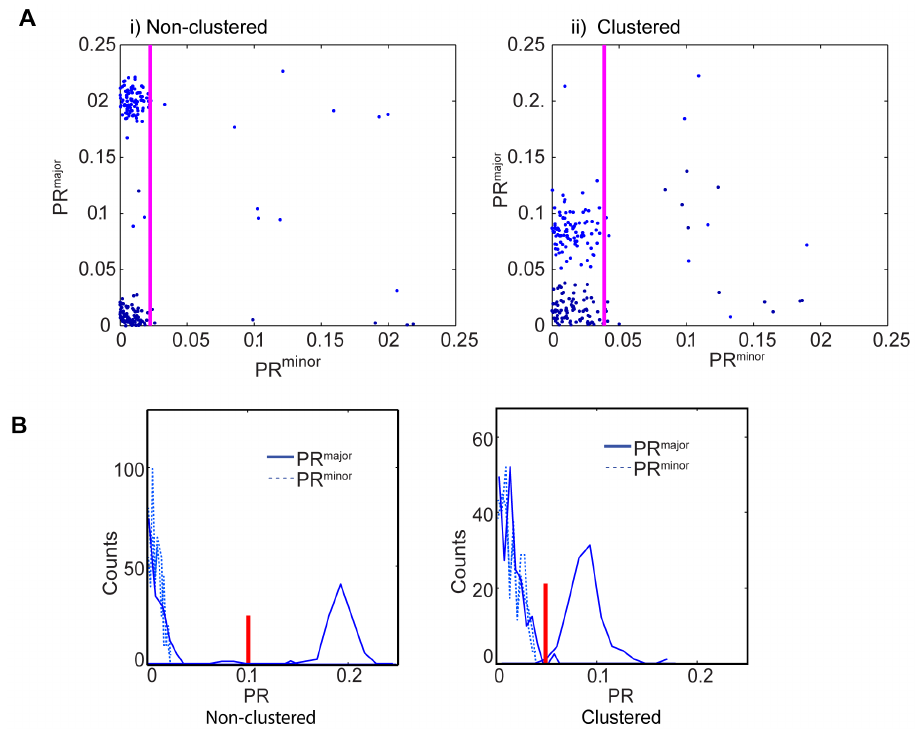
Figure 6. Gating based on PR minor in simulated data. Cell divisions were simulated with ratio 1 (blue color) or 1.5 (red color), 100 divisions for each, with 10% of out of focus "bad data" and PR major (y-axis) was plotted against PR minor (x-axis) ( A ) for non-clustered (i) and clustered (ii) fluorescence. The magenta line show the gating border that to removes 10% outliers of the minor axis polarization, to remove "bad data". PR major of the gated events were plotted as a ( B ). Input for simulations: h was chosen randomly varying from 0 to 90 degrees, distribution of parental radius and total intensity were selected randomly from real distribution from real data, number of clusters in one of the daughter cells was 20 to 100, and the number of clusters in the other daughter cell was multiplied in the simulated ratio giving possible range from 30 to 150.